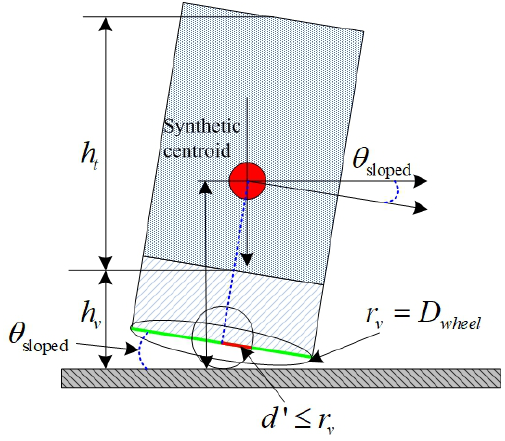
Figure 5. Structural stability